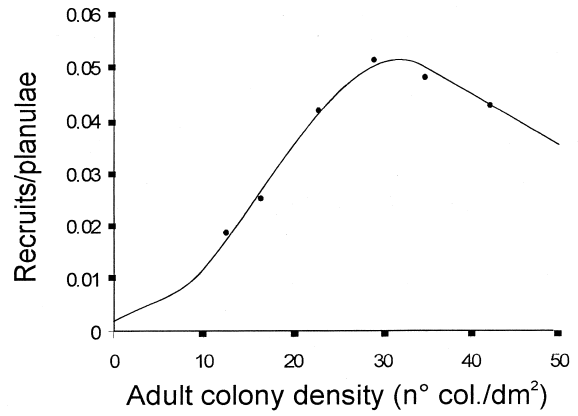
F IG . 3. – Regression curve between larval survival (recruitments-to- larval output ratio) and adult colony density (n° dm -2 ): y = 1.84